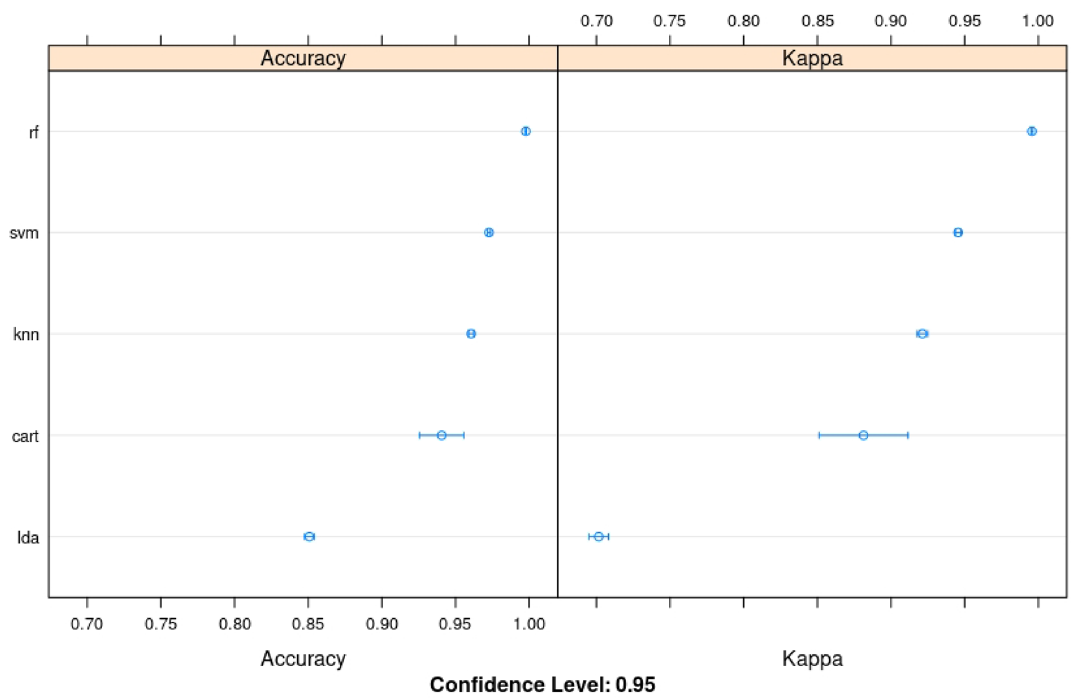
Figure 1. ML algorithms comparison: linear discriminant analysis (LDA) ⇒ linear, classification and regression trees (CART) ⇒ nonlinear, knNearest neigbords (kNN) ⇒ nonlinear, support vector machines (SVM) ⇒ complex nonlinear, random forest (RF) ⇒ complex nonlinear. Number of resamples: